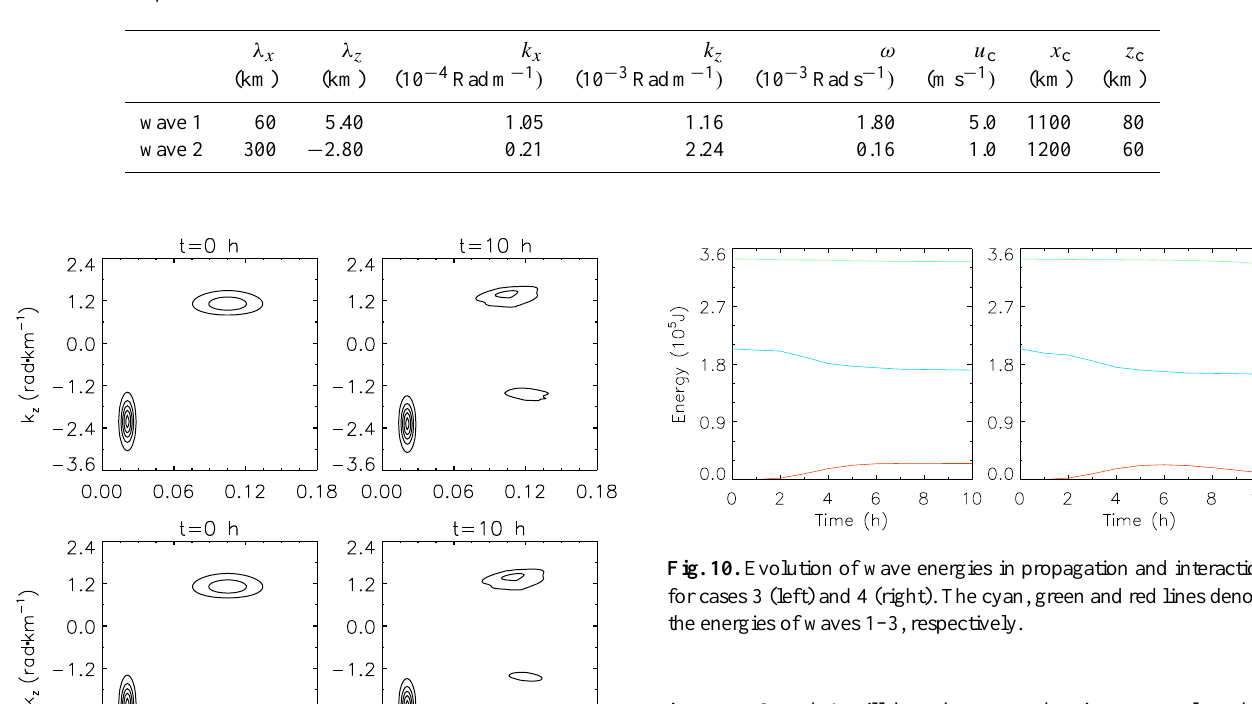
Table 2. Initial parameters of waves 1 and 2 in cases 3 and 4.